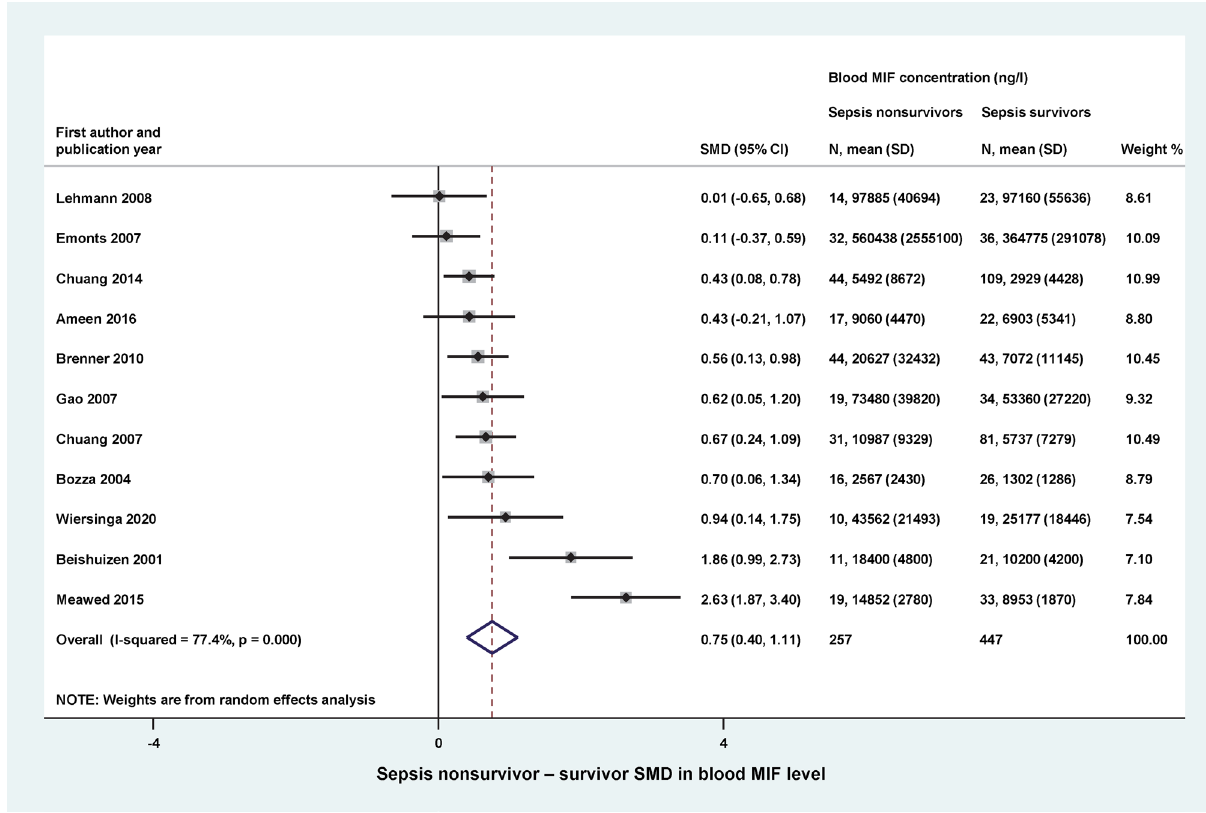
Figure 6. Forest plot of standardized mean differences (SMDs) in blood levels of macrophage migration inhibitory factor (MIF) between sepsis nonsurvivors and survivors. CI confidence interval, SD standard